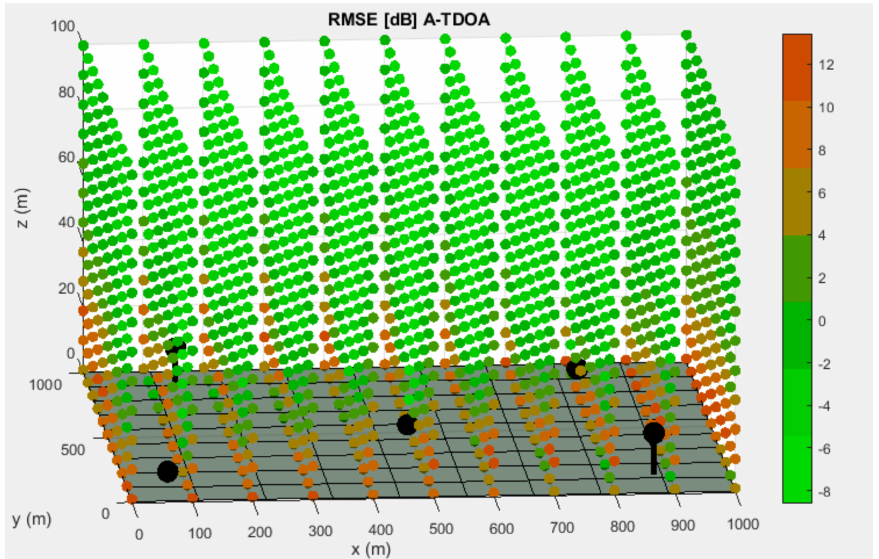
Figure 3. Best distribution of Worker Sensor (WS) and Coordinator Sensor (CS) nodes for the A-TDOA system. The base surface is presented as the grey hyperplane located at the bottom of the picture. The nodes are represented by black spheres with their correspondent holder that links them to the base surface. The CRLB evaluation of the discretization points is displayed according to the right-hand side legend.